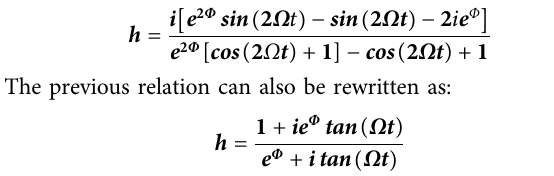
Frontiers in Earth Science |